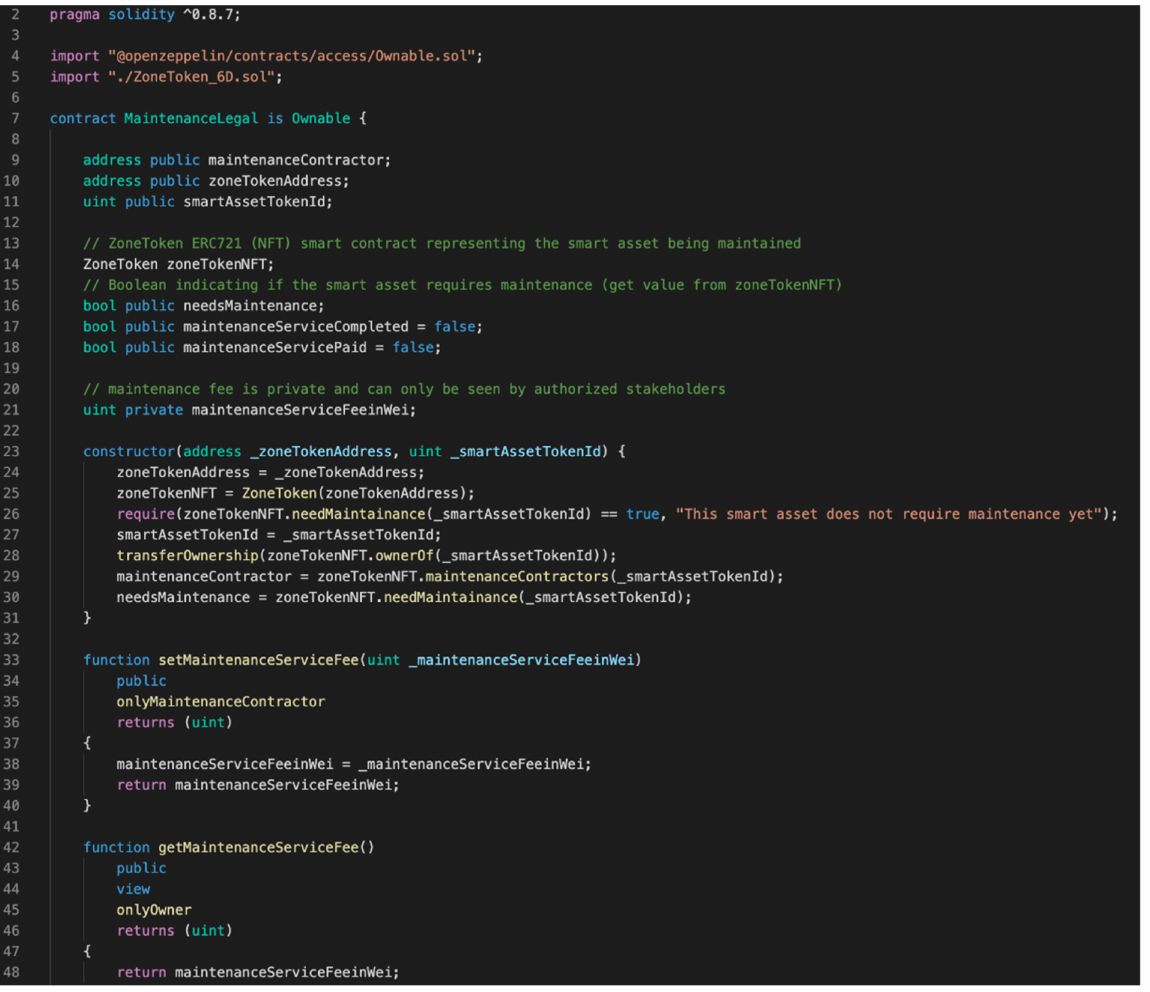
Figure 2. Solidity smart contract extract from the BCDT cD dimension